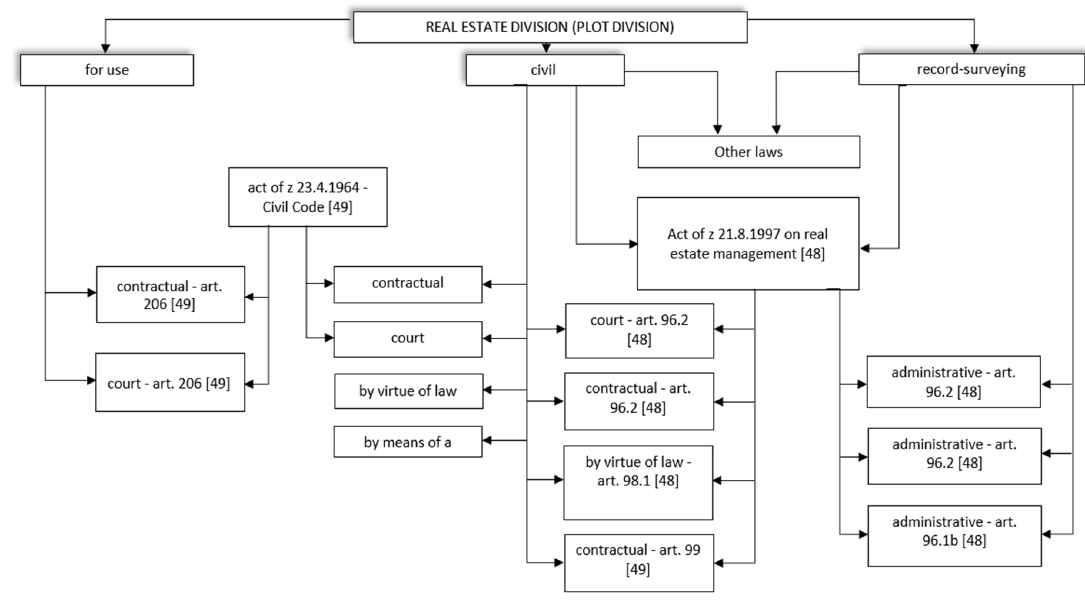
Figure 2. Types of possible real estate divisions. Source: own studies [48–50].